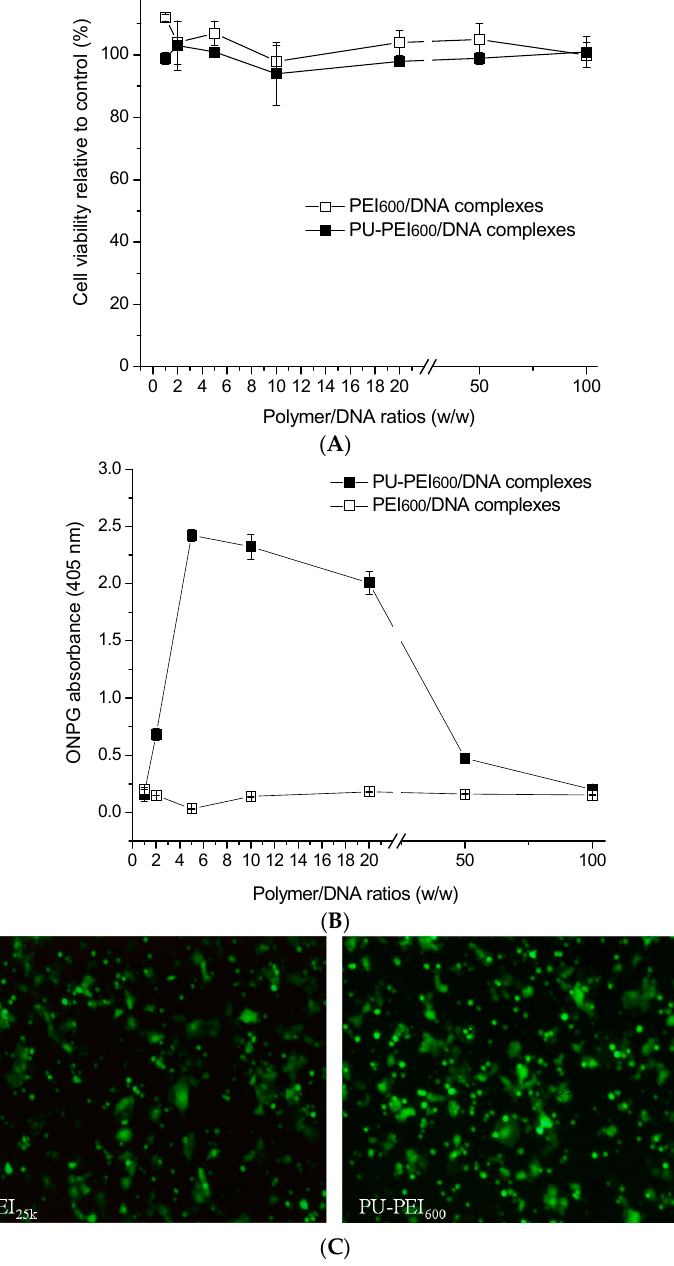
Figure 2. ( A ) Cytotoxicity of PU-PEI 600 /DNA and PEI 600 /DNA complexes in COS-7 cells; ( B ) Transfection efficiency of the polymers/DNA complexes. Data are presented as mean ± SD ( n ≥ 3); ( C ) Transfection efficiency of PU-PEI600/DNA complexes expressing pEEGFP-C2 DNA under a fluorescent microscope (100×).